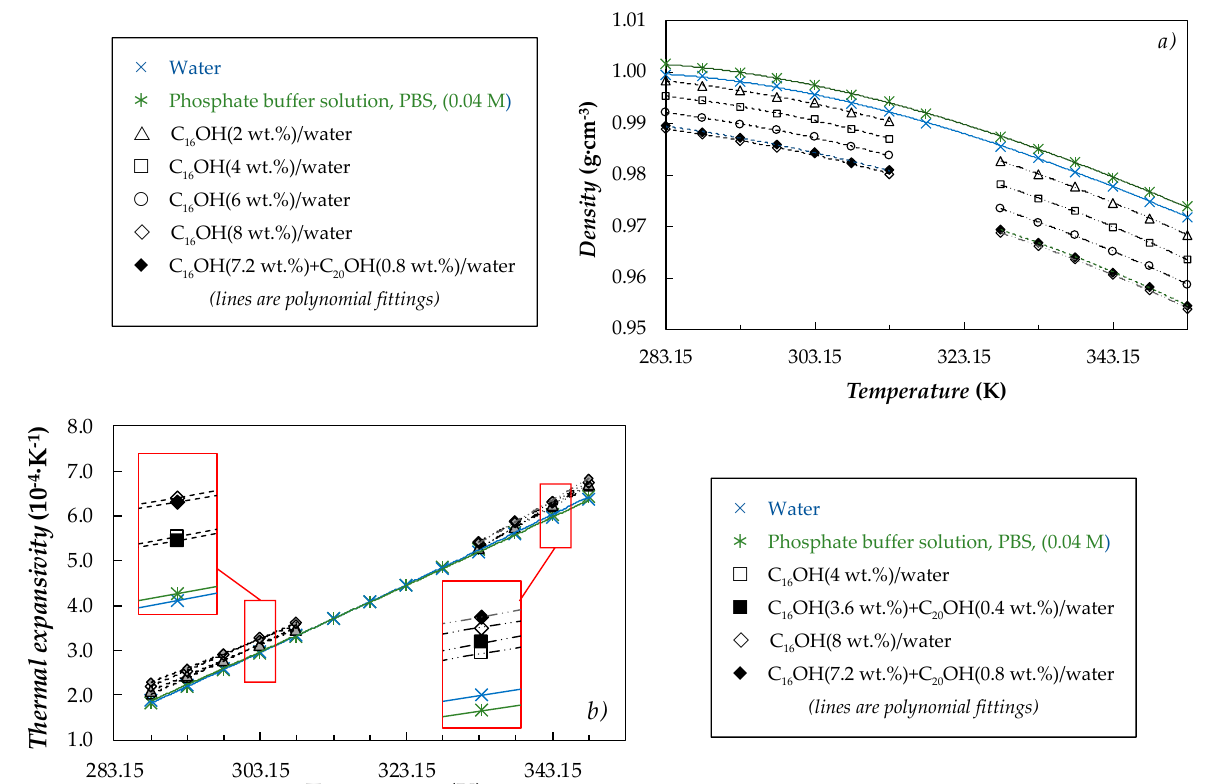
Figure 7. Temperature dependence of the ( a ) density and ( b ) isobaric thermal expansivity for water, phosphate buffer solutions and C 16 OH-in-water or/and C 16 OH + C 20 OH-in-water PCMEs. Temperature uncertainty U ( T ): 0.1 K. Density uncertainty U ( ρ ): 0.05%. Thermal expansivity uncertainty U ( α p ): 4%. Table 4. The A i coefficients and percentage absolute average deviations, AAD% , obtained from sec- ond-order polynomial fittings of the density results. Water-Based Nanoemulsions Phosphate Parameter Buffer Solution, C 16 OH C 16 OH PBS, (0.04 M) (2 wt.%) 0.7549